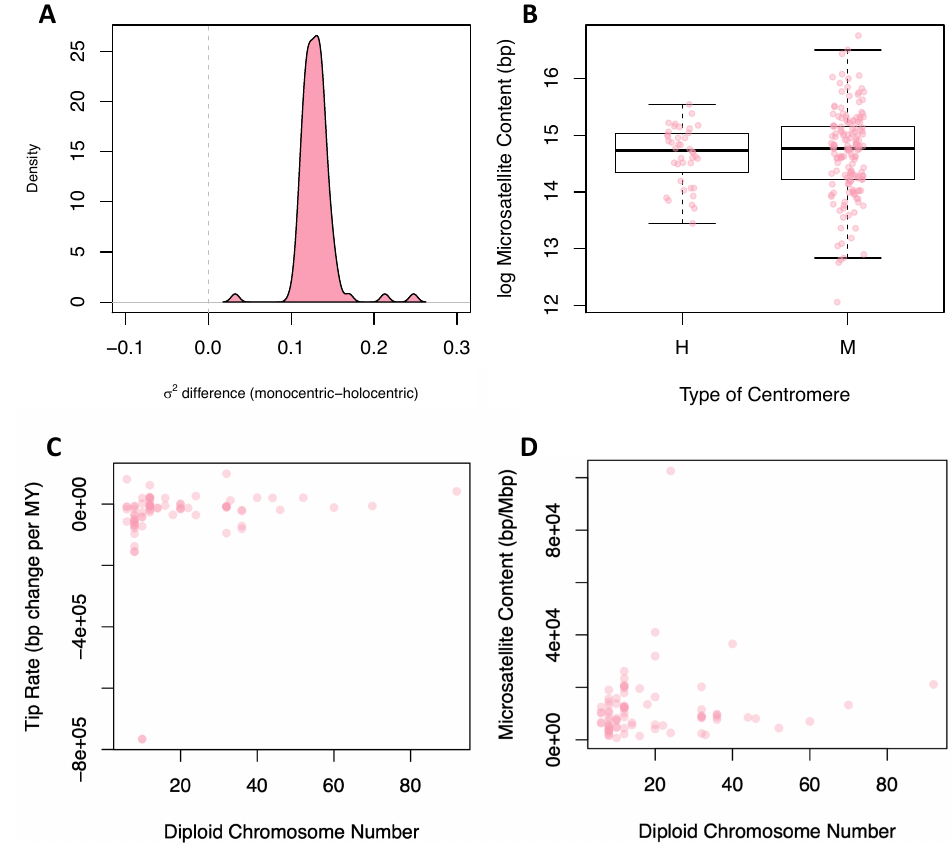
Figure 3. Comparing rates and content to centromere type and chromosome number. ( A ) The di ff erence between the monocentric and holocentric rate predicted under a Brownian motion model for the 100 posterior distribution trees. ( B ) The di ff erence between the microsatellite content in base pairs between holocentric and monocentric species. The y -axis is in the log scale. ( C ) The relationship between microsatellite evolution rates and the diploid chromosome number for each species. ( D ) The relationship between the microsatellite content in bp / Mbp and the diploid chromosome number for each of the